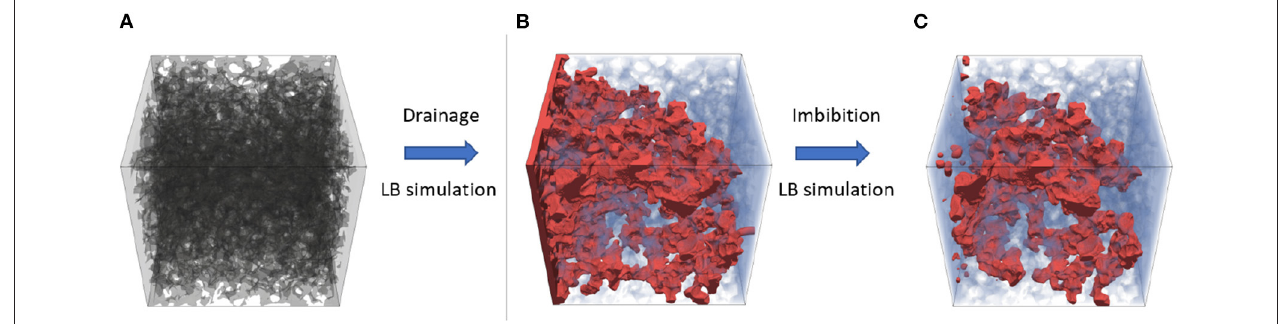
FIGURE 9 | LB simulations of drainage and imbibition processes on the Berea sandstone sample to obtain end point saturations. (A) pore space of the sample (B) end of drainage process (C) end of imbibition process. CO 2 is shown in red. Brine is not rendered.